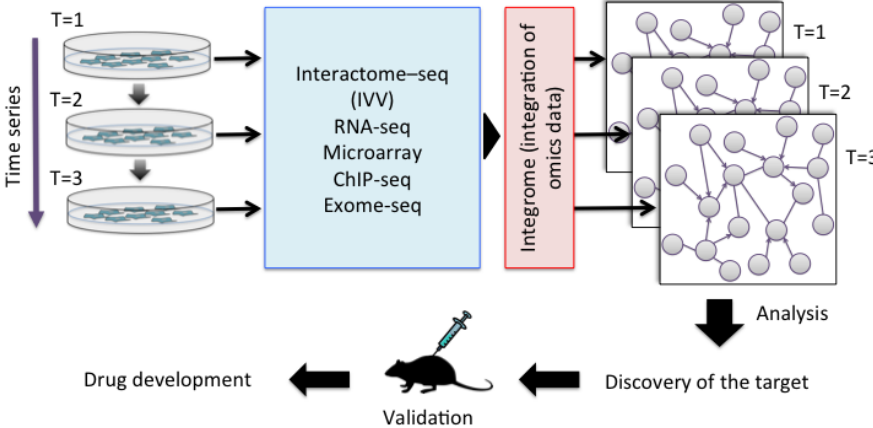
Figure 2. Integration of multi-omics data in the process of personalized